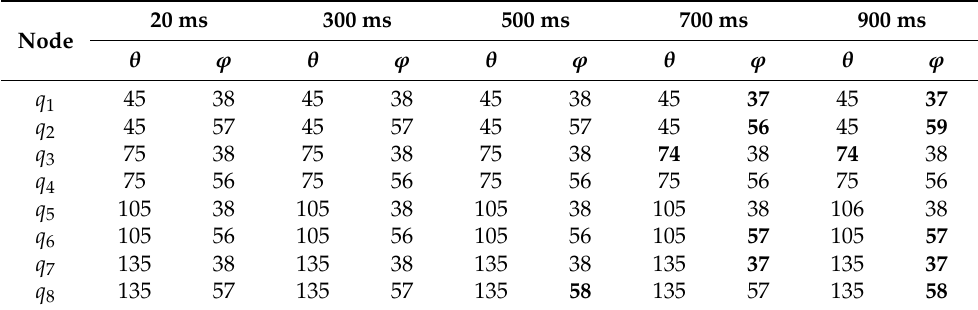
Table 2. Identified sound source (cluster center) coordinates with different reverberation time.